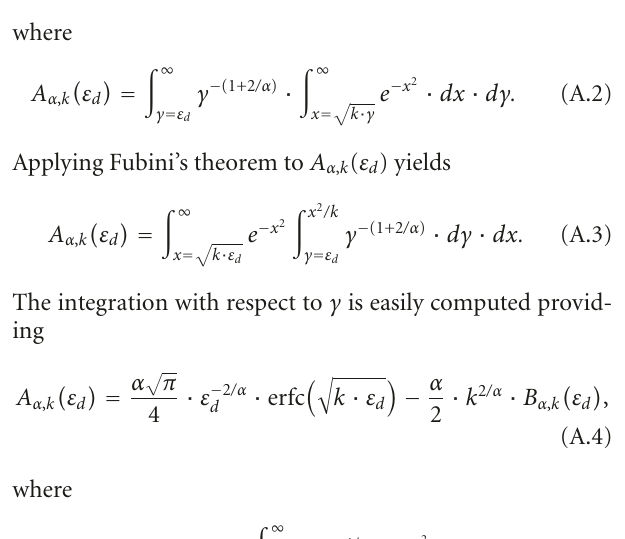
Figure 13: Connectivity under block fading, AWGN ( m > 10) and Rayleigh ( m = 1) conditions. The connectivity and the nonisolated node probabilities have been assessed by simulation. The theoretical nonisolated node probability according to (3) for the approximated mean node degree given in (49) is also